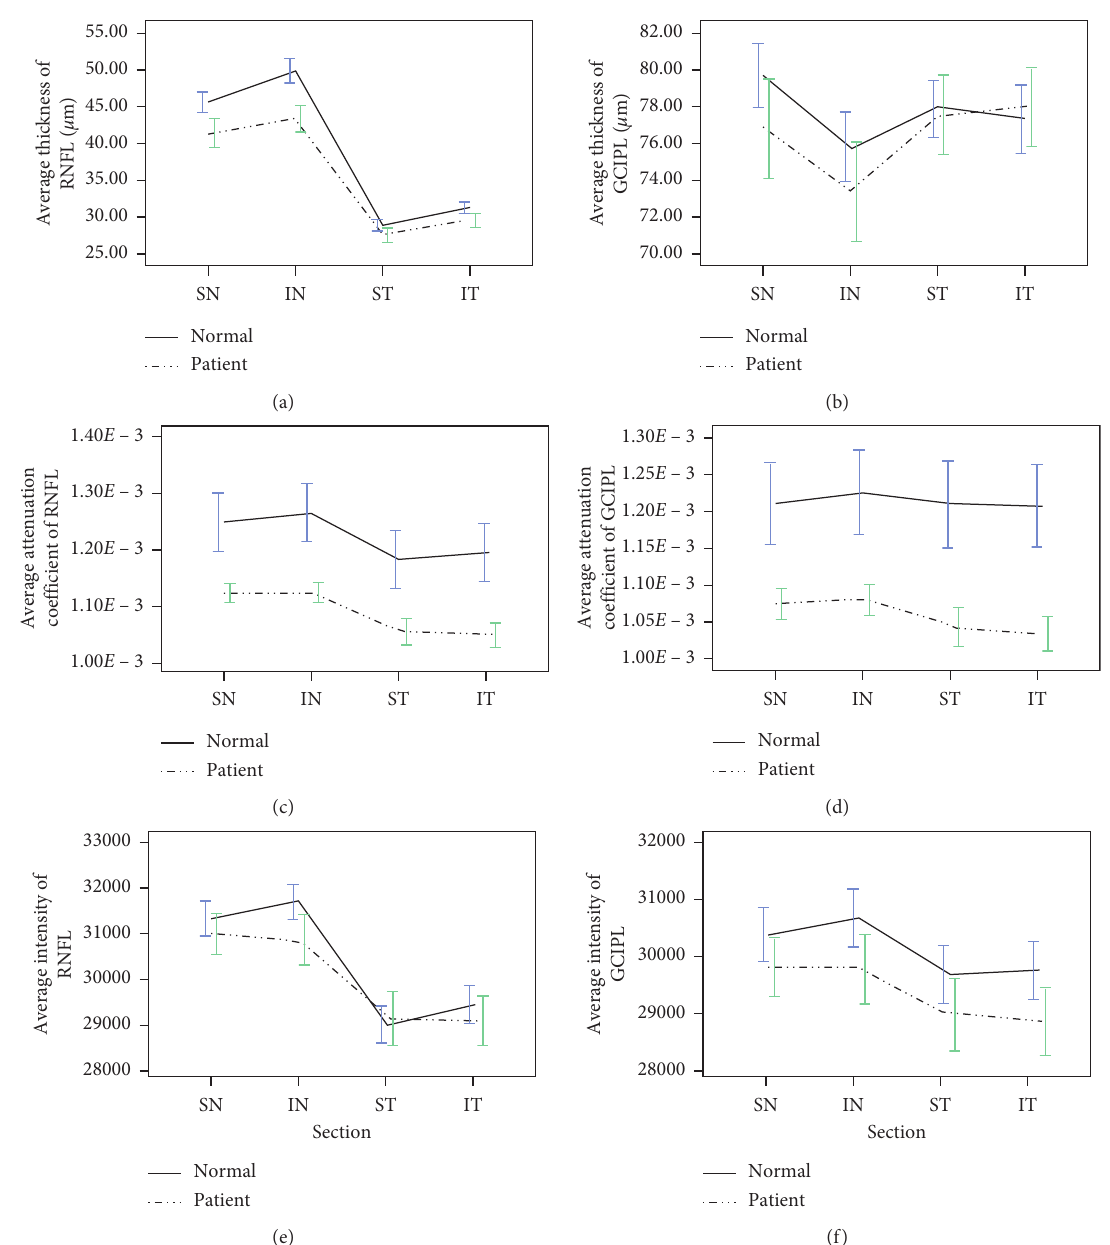
Figure 2: Comparison of thickness ( μ m), attenuation coefficient ( μ m − 1 ), and corrected intensity (AU) in the RNFL and GCIPL between patients and controls according to each ( P � 0 . 016) (Figure 3(b)) and positive standardized beta’s values in most quadrants of GCIPL (ranged from 0.004 to 0.088, except − 0.038 in IT quadrant) in controls without significance.